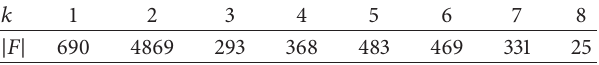
Table 2: The number of frequent 𝑘